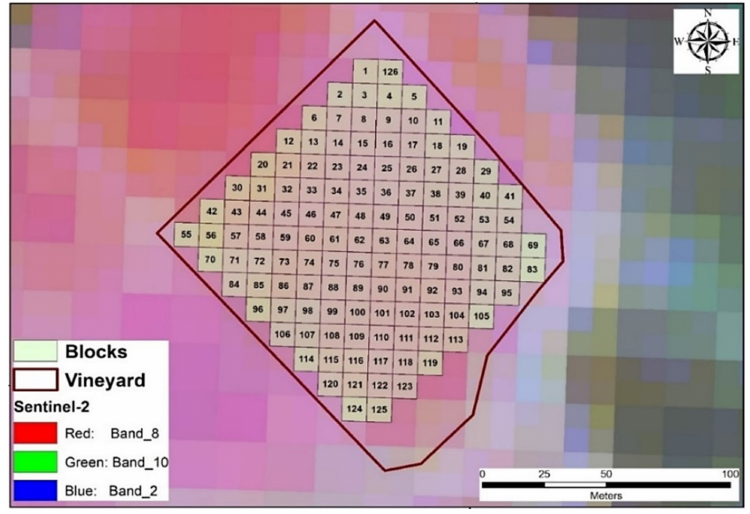
Figure 5. The study area divided into a grid of 126 blocks of the same